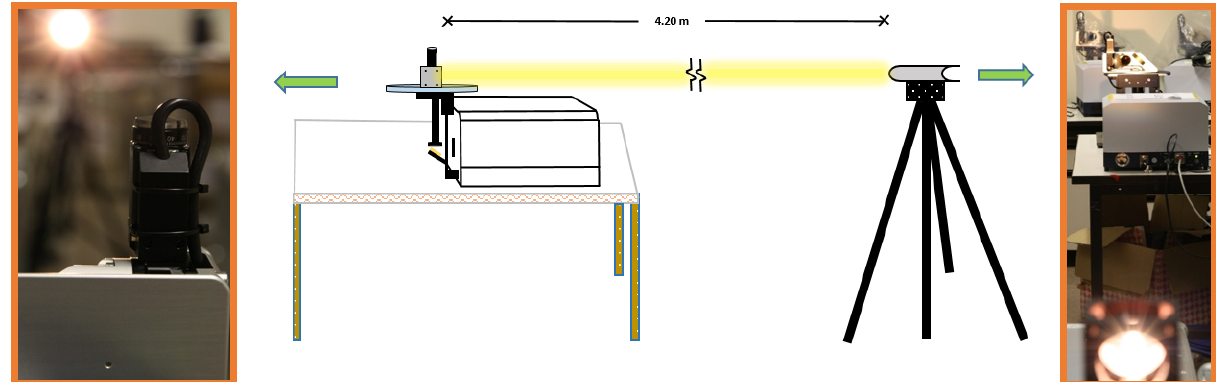
Figure 2. Set-up of the open-path measurements. The central part of the illustration schematically shows all the components and the alignment of the experimental set-up, while in left and right sides photographic close-up views are presented. The left photograph shows the view in the opposite direction from the spectrometer towards the lamp unit, while the right photograph shows a view from the lamp unit (bottom) towards the spectrometer with its solar tracker (top): the lamp in the bottom part and the instrument located at a distance of 4.20m.